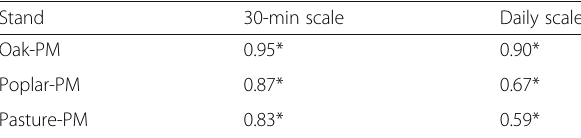
Table 2 Correlation coefficients ( r ) between reference ET_PM and estimated ET gw values